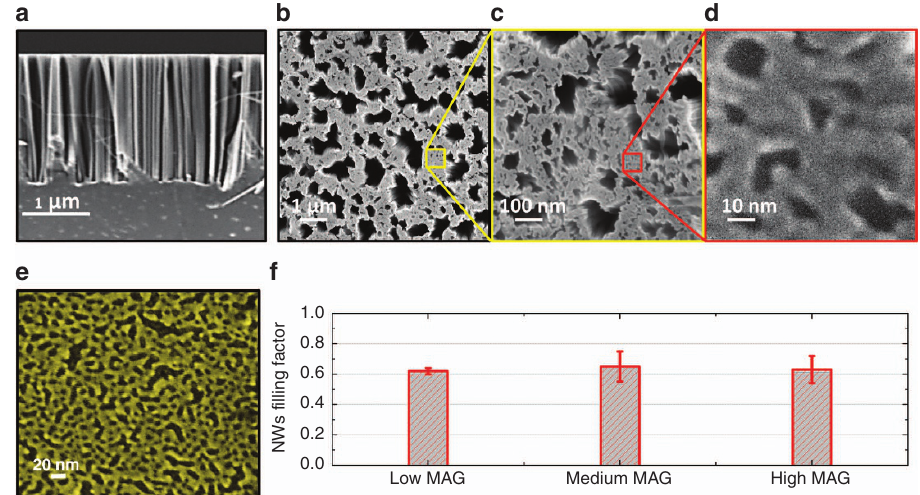
Figure 1 SEM images of Si NWs obtained by the metal-assisted wet etching technique. ( a ) Cross-section SEM image of Si NWs obtained by the metal- assisted wet etching technique. ( b , c and d ) Plan view SEM images of a Si NW sample obtained at three different magni fi cations (25 k×, 250 k× and 2500 k×). The structure is arranged in a Russian-nesting-doll-like distribution: in particular, panel c is the higher magni fi cation of the sample area inside the yellow square in panel b, and panel d is the higher magni fi cation of the sample area inside the red square in panel c. ( e ) Plan view SEM image of interconnected gold fi lm deposited on a Si (111) surface. ( f ) Silicon surface coverage histogram for the plan view SEM images shown